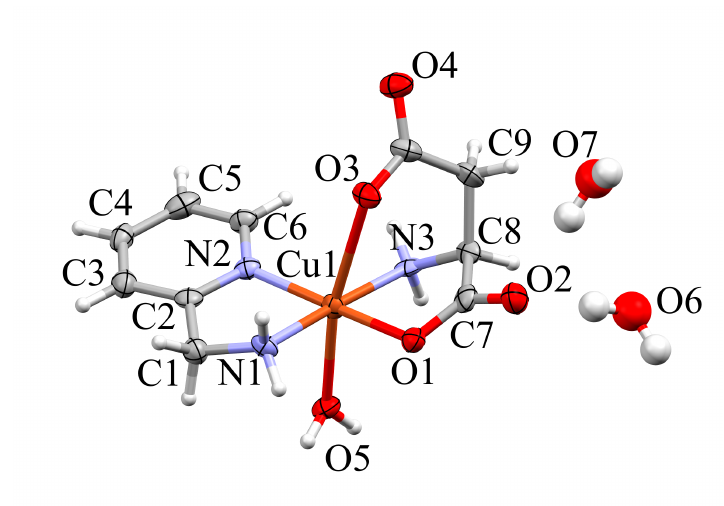
Figure 2. Expanded asymmetric unit of 1 (Mercury, [42]). Non-hydrogen atoms in the complex are shown as ellipsoids (70% probability), H as spheres with fixed radius of 0.15 Å, atoms in co-crystallized water molecules as spheres with 0.25 × the van der Waals radii. Coordination distances (Å): Cu1–N1 = 1.989(5), Cu1–O1 = 1.991(4), Cu1–N2 = 1.992(5), Cu1–N3 = 2.010(5), Cu1–N5 =